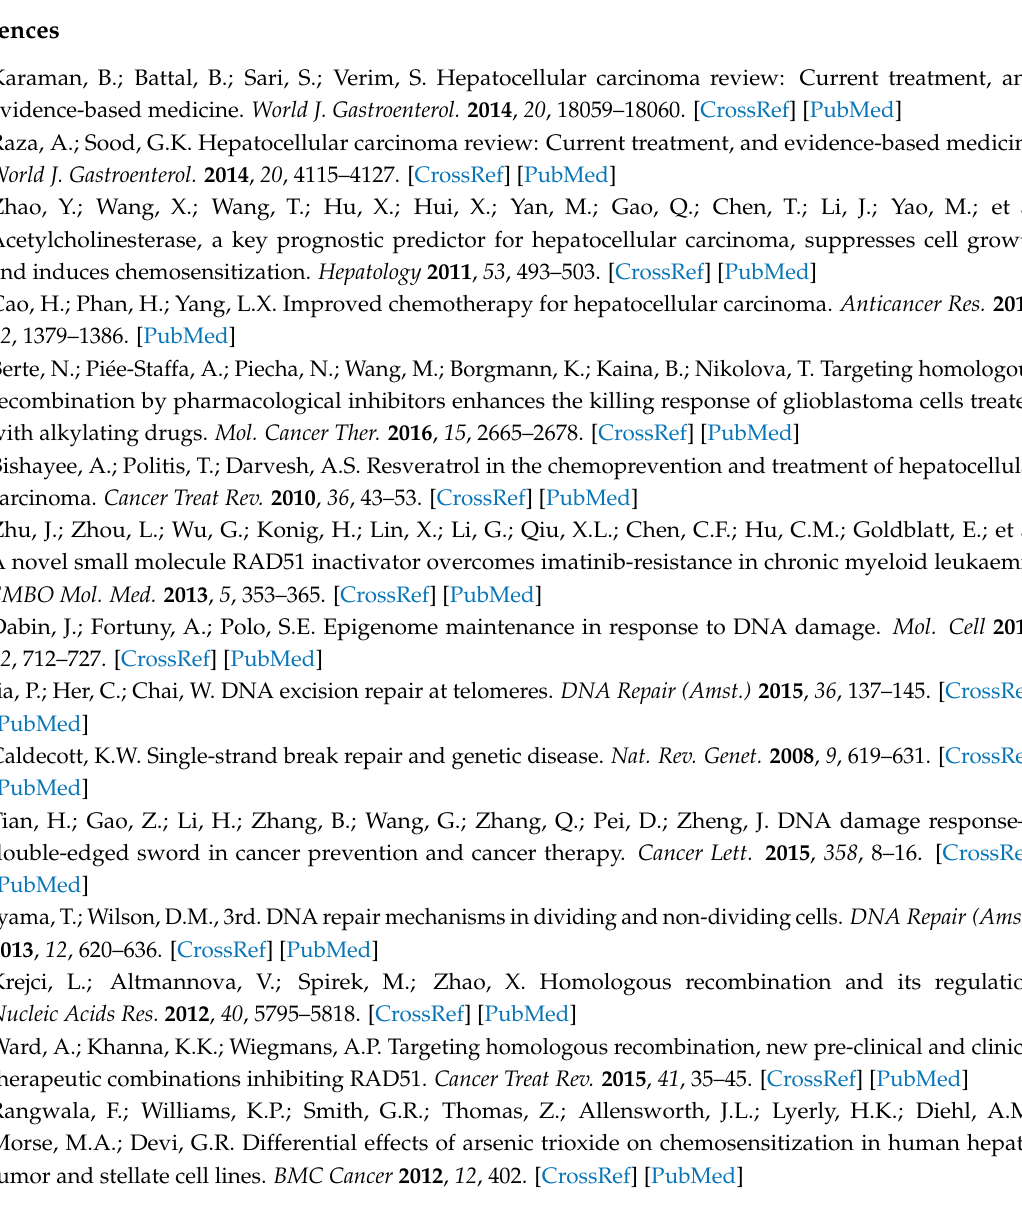
(VP16)-induced apoptosis of Huh7 cells; Figure S4: Melatonin suppressed expression of DNA repair-related proteins; Figure S5: Whole-transcriptome sequencing analysis of different genes after melatonin